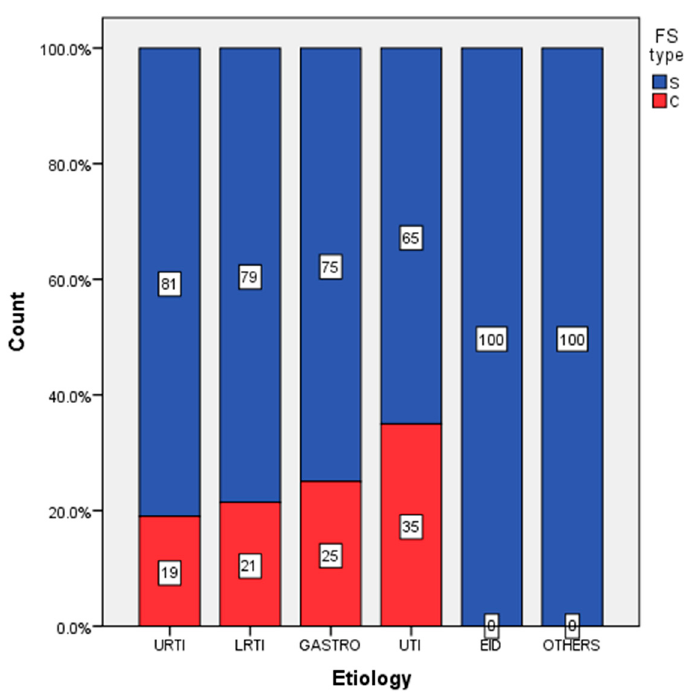
Figure 1. Distribution of simple and complex febrile seizures according to etiology (upper respira- tory tract infection (URTI), lower respiratory tract infection (LRTI), urinary tract infections